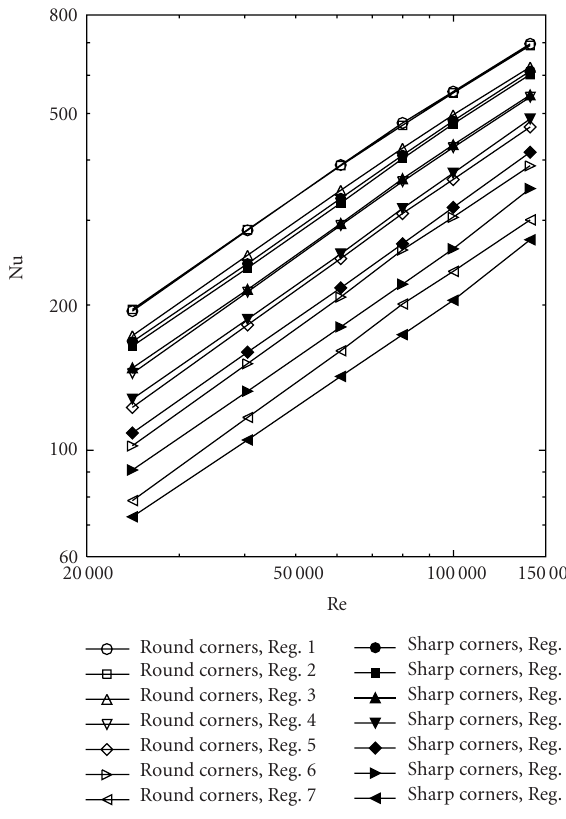
Figure 9: Comparison between the numerical results for sharp- and round-corner ribs with 25% blockage ratio ( e/D h = 0 . 25, P/e = 10).